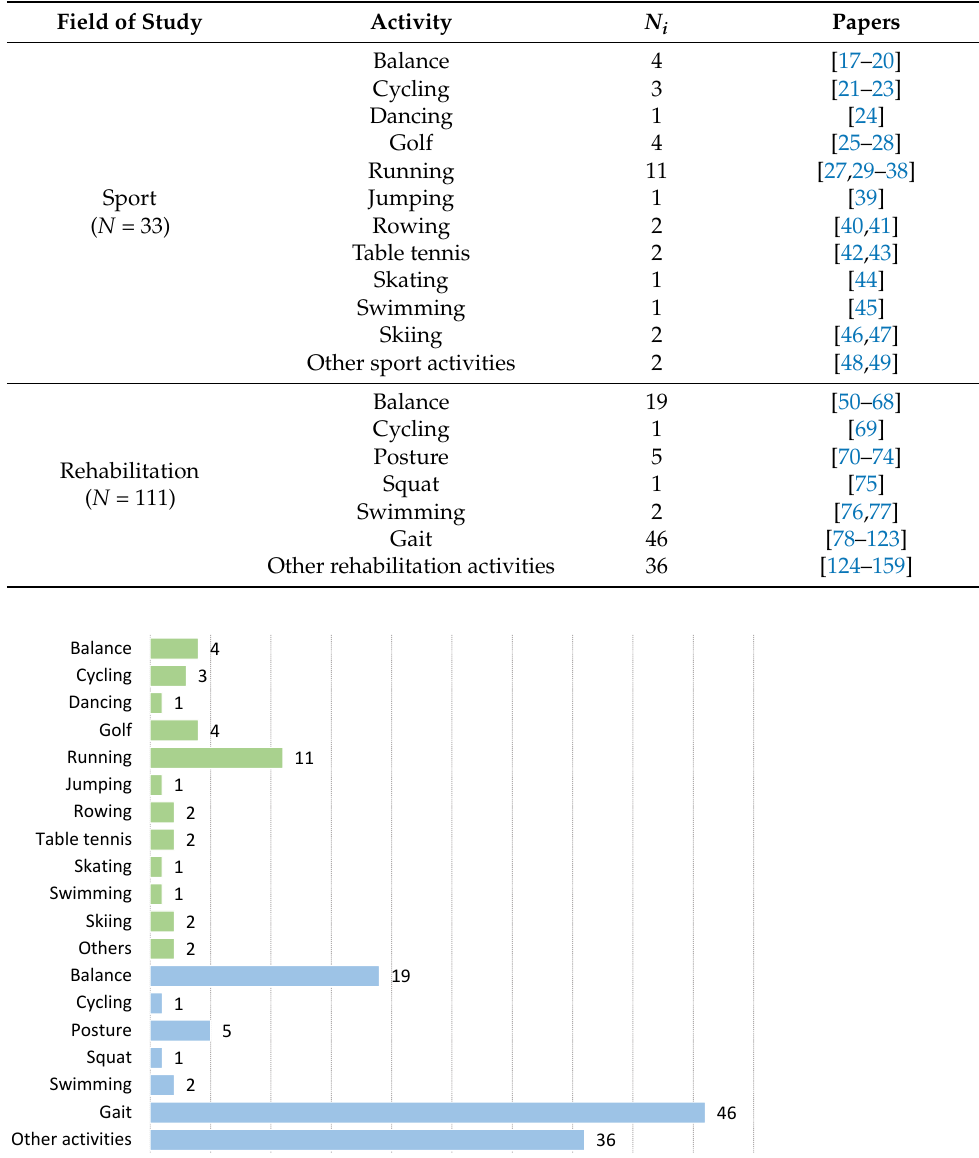
Table 1. Papers classified according to the field of study and specific physical activity.